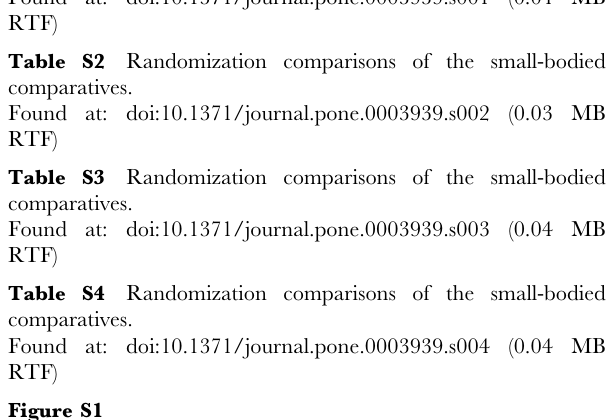
Figure S2 Found at: doi:10.1371/journal.pone.0003939.s006 (4.13 MB TIF) Figure S3 Found at: doi:10.1371/journal.pone.0003939.s007 (4.10 MB TIF) Figure S4 Found at: doi:10.1371/journal.pone.0003939.s008 (3.35 MB TIF) Figure S5